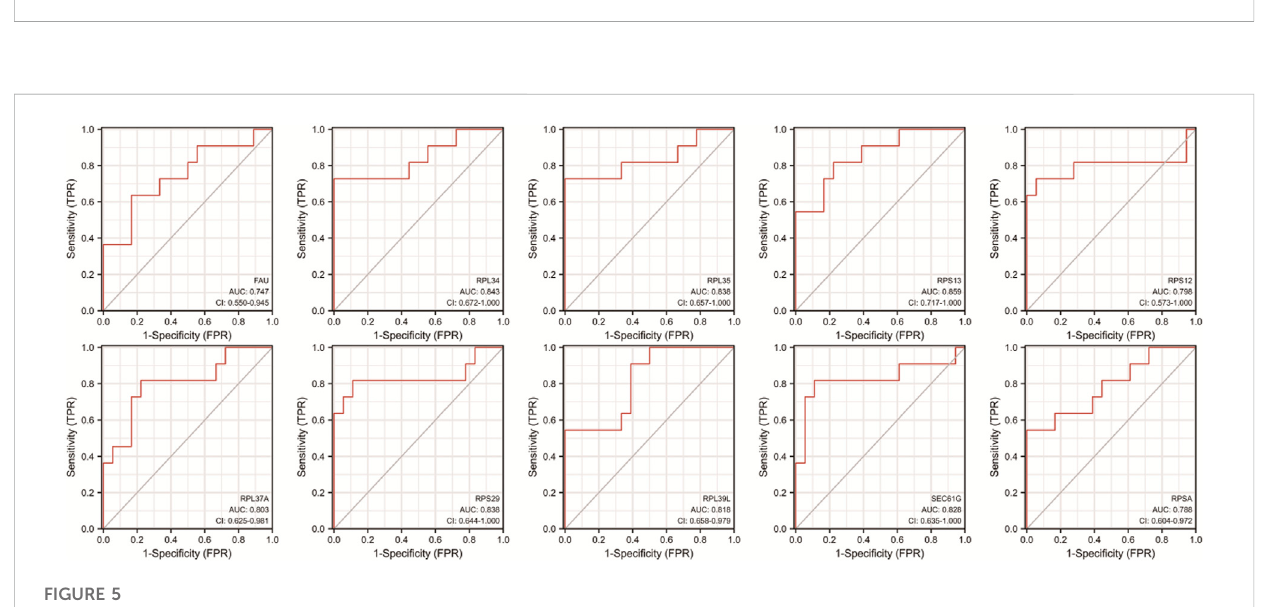
FIGURE 4 PPI network of DEGs and four cluster modules extracted by MCODE. (A) The interaction network between proteins coded by DEGs was comprised of 63 nodes and 250 edges. The larger and darker the circle, the more important the gene. (B) Interaction of top 10 genes calculated by MCODE.